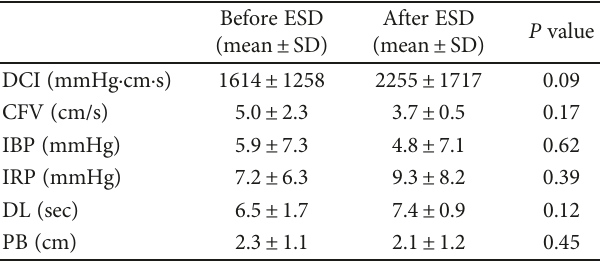
Figure 6: Representative case from group B in which there were changes after endoscopic submucosal dissection (ESD). Patient number 25 is a typical case from group B (more than 2/3 circumferential resection). Symptom score and distal contractile index (DCI) were increased after ESD compared with before ESD. The yellow arrow indicates the resected region (29 – 32 cm from the incisor column). DCI increased signi fi cantly in the resected Table 4: High-resolution manometry data for the group showing increasesinsymptomscoresafterendoscopicsubmucosaldissection.